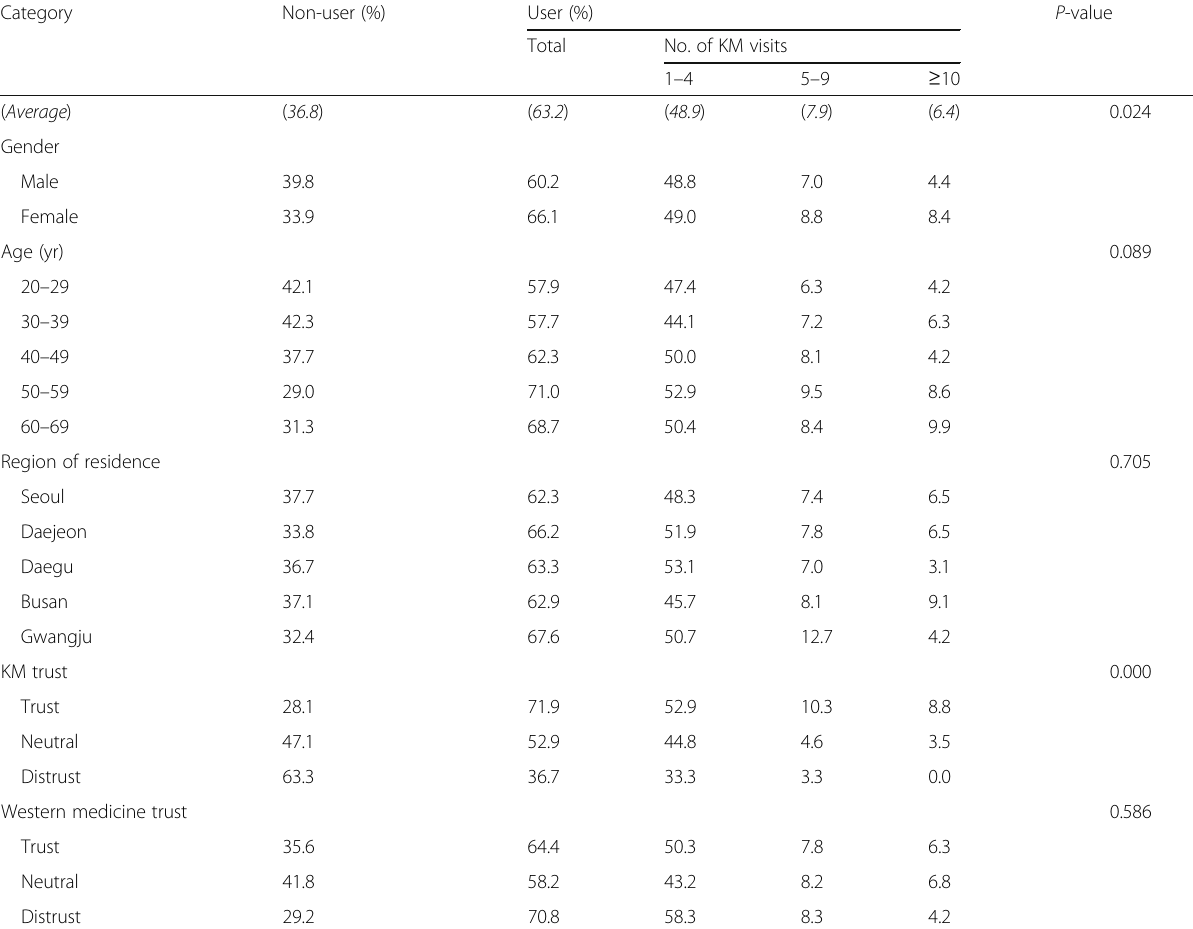
Table 5 Frequency of visits to KM clinics over the past 12 months in 2014